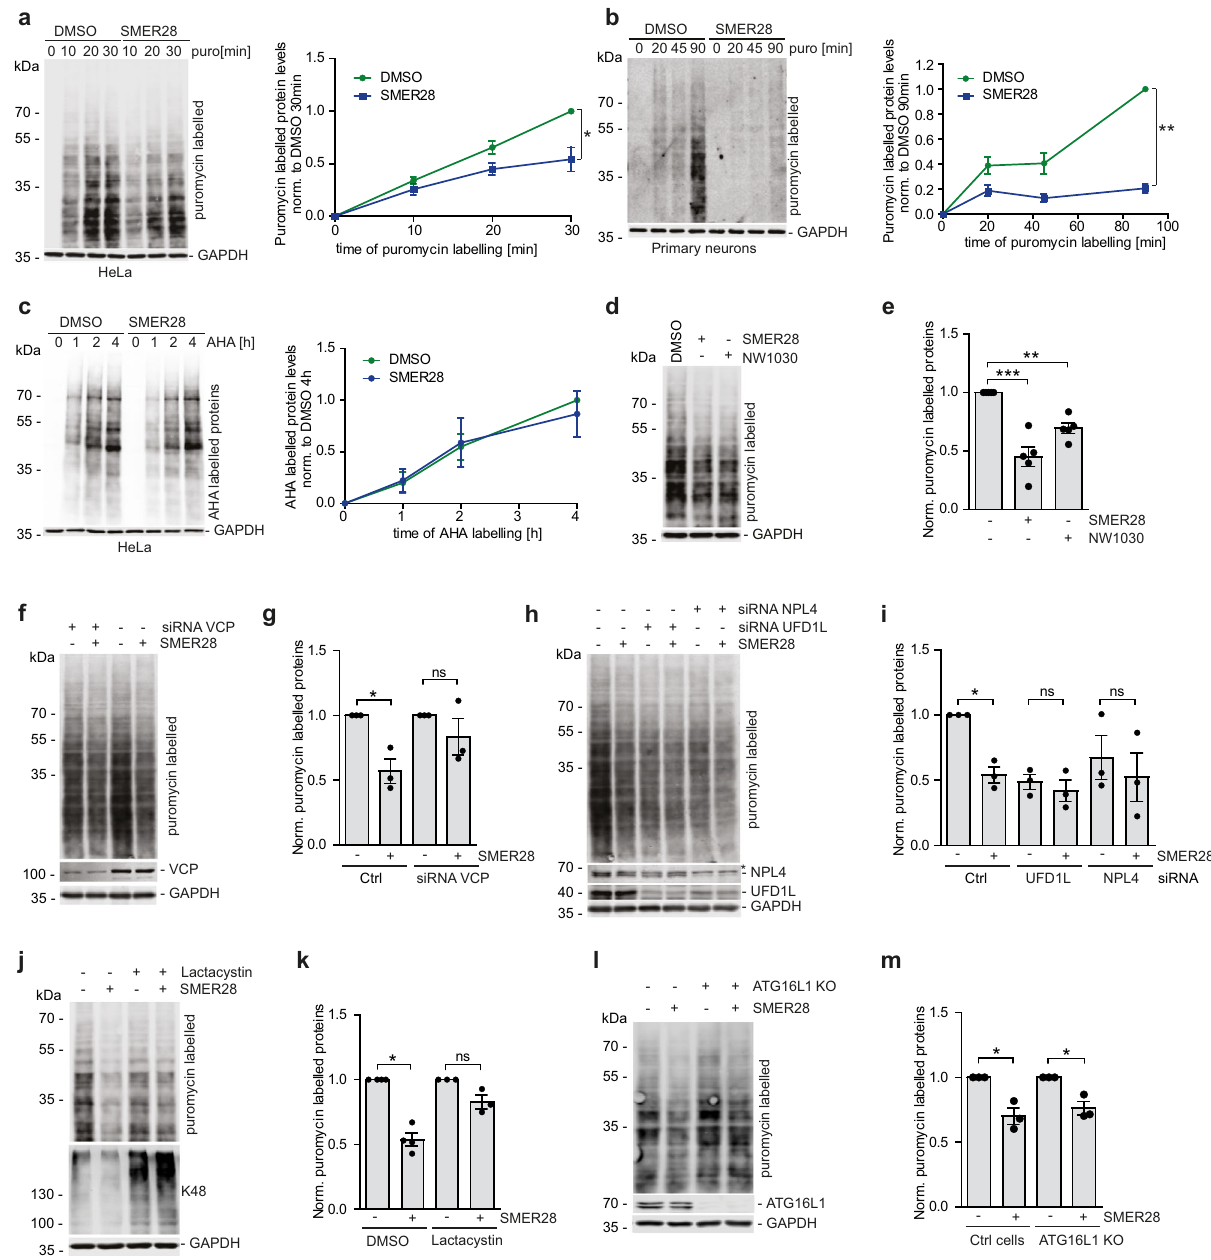
Fig. 7 SMER28 enhances degradation of short-lived misfolded proteins by UPS in VCP and UFD1L/NPL4 dependent manner. a , b HeLa cells ( a ) or primary cortical neurons ( b ) were pre-treated with 20 µ M SMER28 or DMSO for 4 h, followed by treatment with puromycin for indicated time points, n = 3; ( a ) P = 0.0478, ( b ) P = 0.0022. c HeLa cells were pre-treated for 1 h with 20 µ M SMER28 or DMSO in a medium deprived of methionine, followed by the addition of methionine analog L-azidohomoalanine (AHA) for indicated time points. Cells were lysed and analyzed by Western blotting using streptavidin antibody, n = 3. d , e HeLa cells were pre-treated with 20 µ M SMER28, 10 µ M NW1030, or DMSO for 4 h, followed by treatment with puromycin for 15 min, n = 5; quanti fi cation in ( e one-way ANOVA: P < 0.0001 with post hoc Tukey test, SMER28 P < 0.0001, NW1030 P = 0.0213). f – i HeLa cells was treated with siRNA against VCP ( f , g ) and UFD1L or NPL4 ( h , i ). After 48 h cells were pre-treated with 20 µ M SMER28 or DMSO for 4 h, followed by treatment with puromycin for 15 min, n = 3; quanti fi cation in ( g one-sample t test, Ctrl P = 0.0442) and ( I SMER28 P = 0.0175). j , k HeLa cells were pre-treated with 20 µ M SMER28 or DMSO for 3 h, followed by 1 h pre-treatment with 2 µ M Lactacystin and 15 min with puromycin, n = 3; quanti fi cation in ( k , one sample t test, DMSO P = 0.0026). l , m ATG16L1 knockout, and control cells were pre-treated with 20 µ M SMER28 or DMSO for 4 h, followed by treatment with puromycin for 15 min, n = 3; quanti fi cation in ( m one sample t test, control P = 0.0415, ATG16 KO P = 0.046). ( a , b , d , f , h , j , l ) Cells were lysed and analyzed by Western blotting. Puromycin-labeled proteins were detected using anti-puromycin antibody. Bar graphs data presented as normalized mean ± SEM. * P < 0.05, ** P < 0.001, *** P < 0.0001, paired two-tailed Student ’ s t test unless stated otherwise; *, unspeci fi c band; ns not signi fi cant. Source data are provided as a Source Data fi